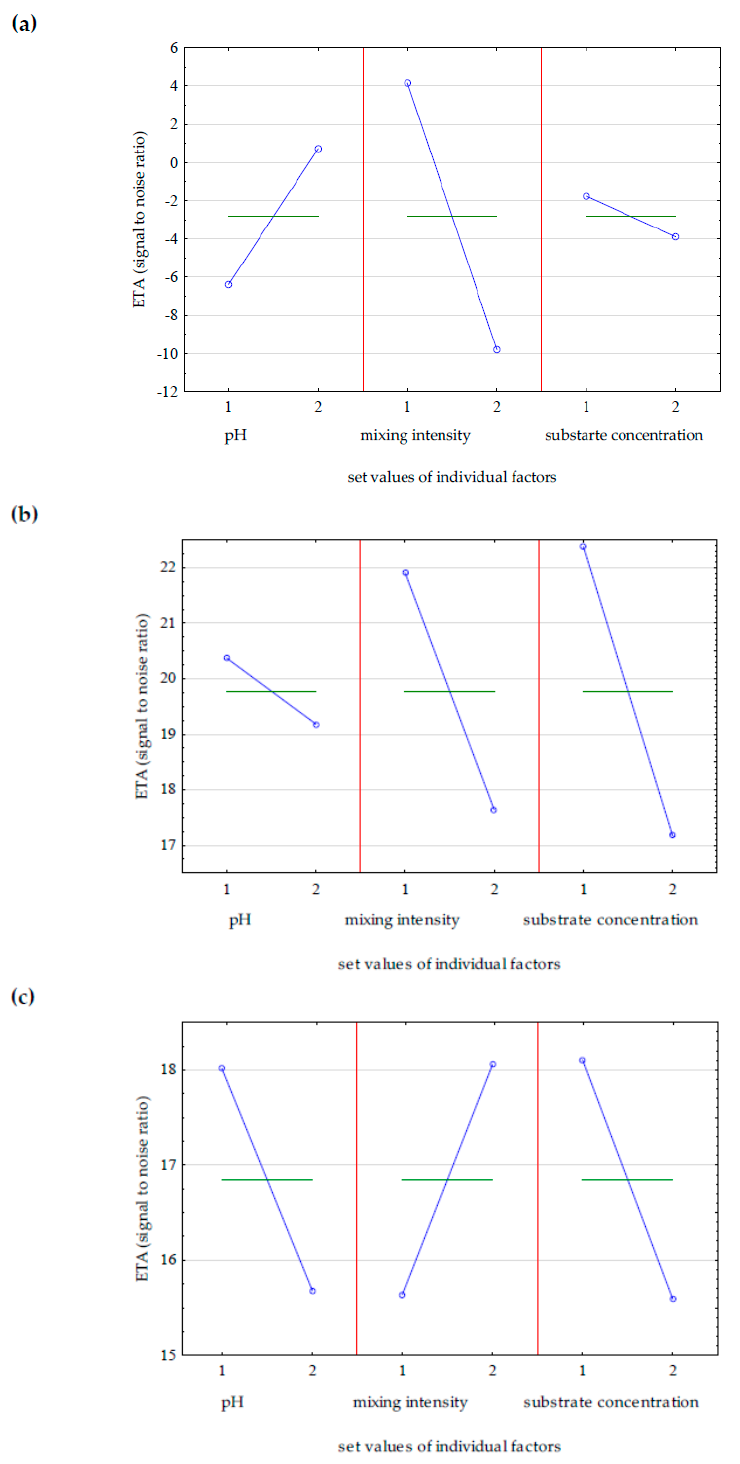
Figure 3. The influence of individual factors on the Eta value calculated as the larger, the better when the goal was to maximize ( a ) the concentration of γ -decalactone, ( b ) the biomass yield, and ( c ) the number of living cells of Y. lipolytica in batch culture. The values of the controlled factors used in the batch cultures of Y. lipolytica are described in Table 2.